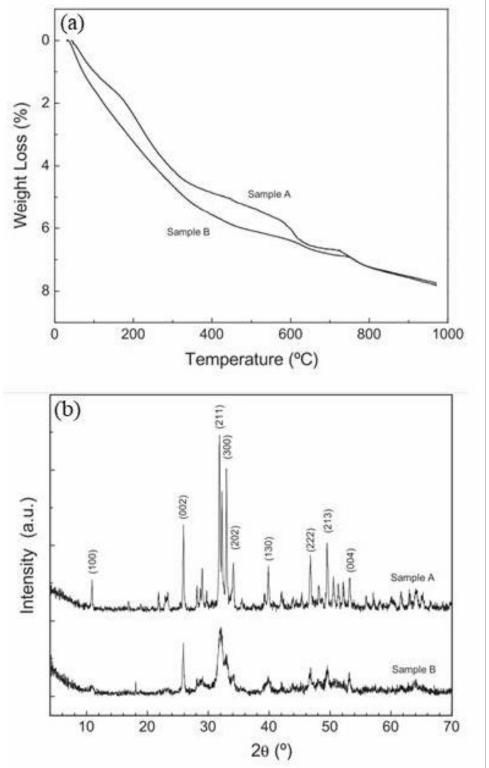
Figure 14. Phosphate samples obtained using 0.4 M NaHPO 4 and 500 mL of 0.6 M Ca(NO 3 ) 2 · 4H 2 O at pH ~12.5 (sample A) and pH ~8.5 (sample B): ( a ) thermogravimetric (TGA) results, and ( b ) X-ray diffraction (XRD) patterns for samples A and B [42]. Reproduced with permission from Bastidas, D.M. et al., Constr. Build. Mater.; published by Elsevier,